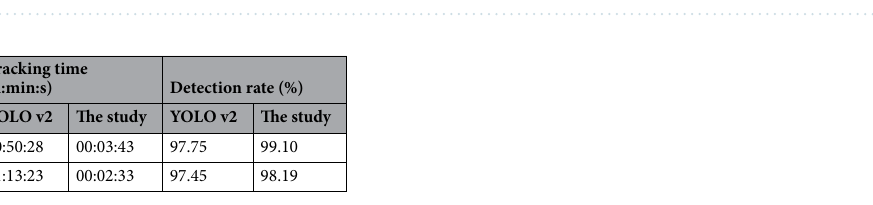
Figure 13. Dot distribution over the entire maze of another single rat in ( A ) the TBI group and ( B ) in the Sham group on Day 28.